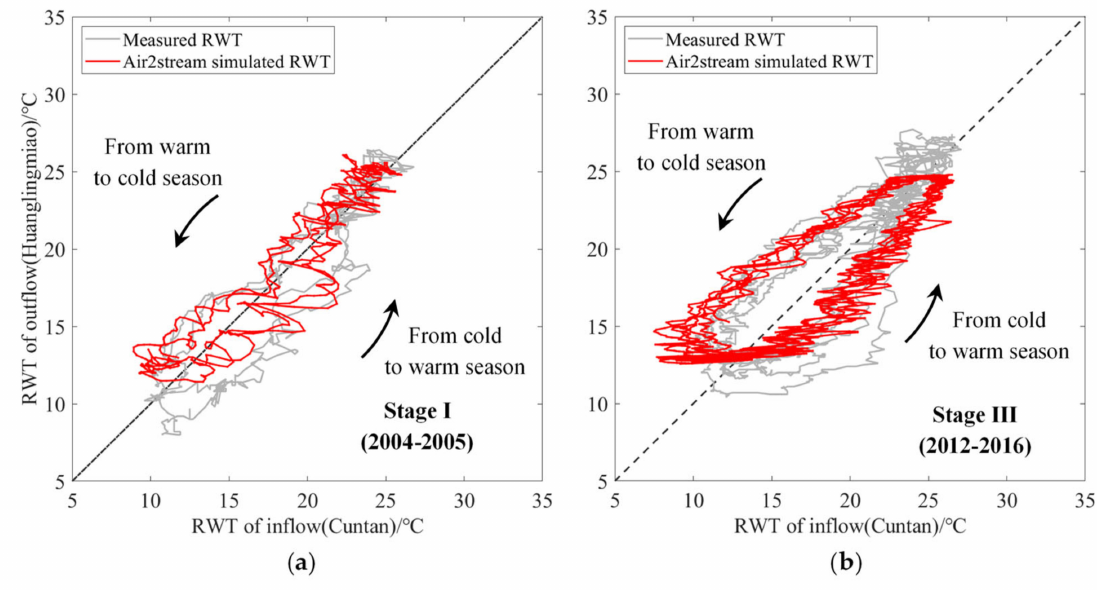
Figure 8. Inflow and outflow RWT interrelationship during ( a ) Stage I and ( b ) Stage